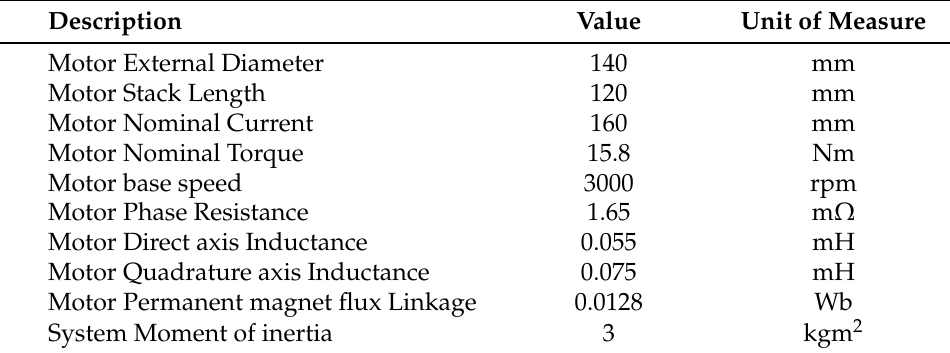
Figure 8. Motor inductances versus stator phase current. Table 1. Main parameters for the